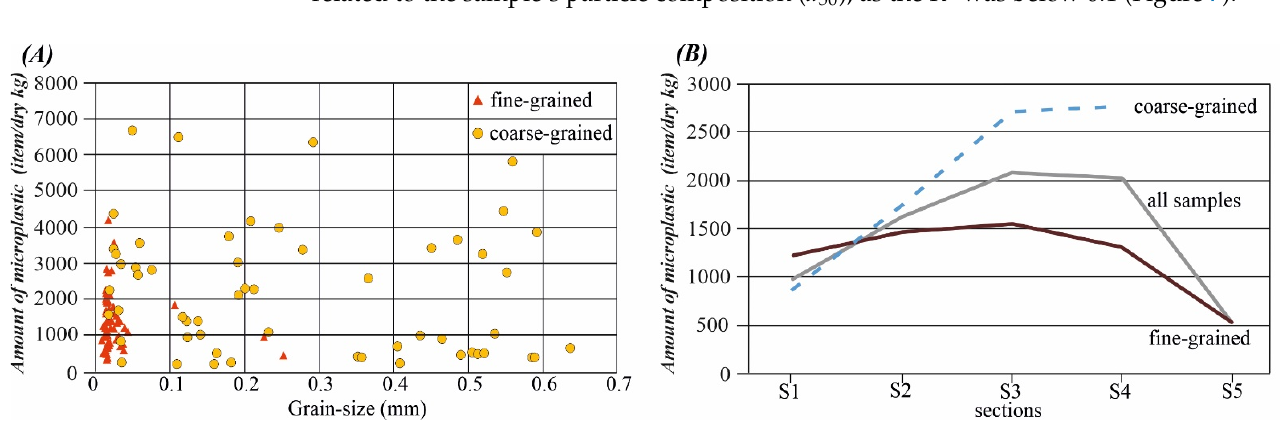
Figure 7. ( A ) Relationship between the grain size ( d 50 ) of the samples and their microplastic content (item/dry kg). ( B ) Mean microplastic content (item/dry kg) of the fine-grained and coarse-grained sediments collected from the various sections of the Tisza in 2020.